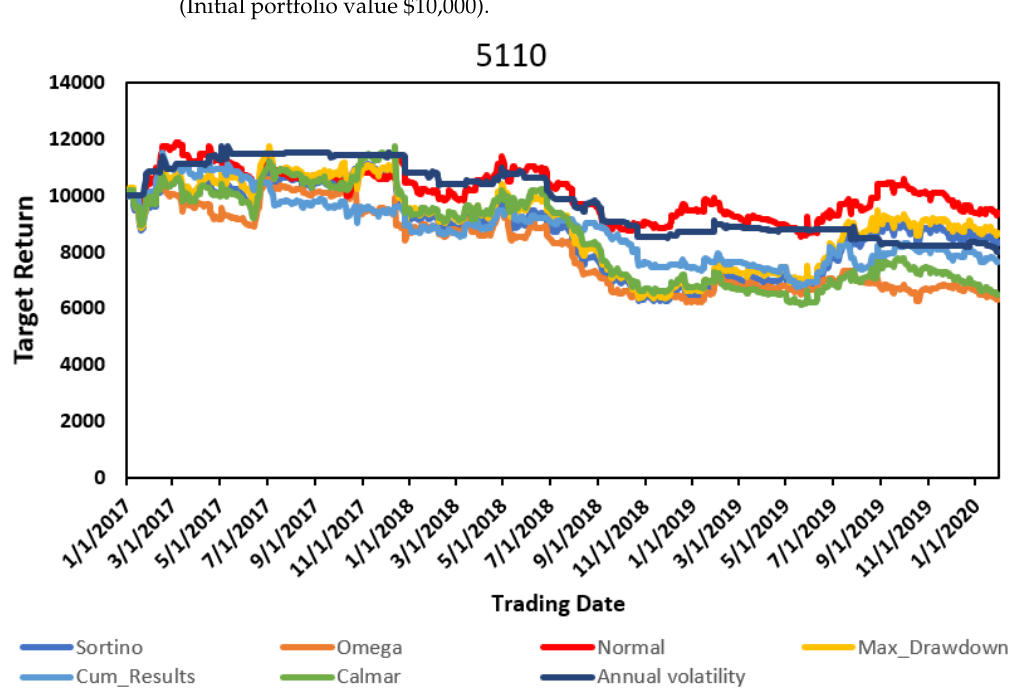
Figure 19. Outcome of 5110 stock target return during model training with different reward functions (Initial portfolio value